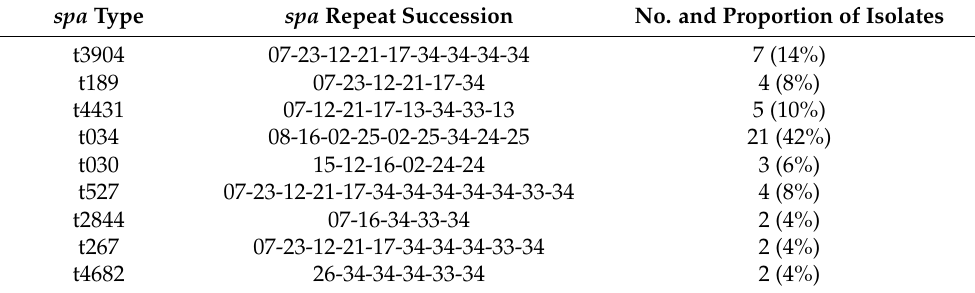
Table 3. spa types of the isolated S. aureus .